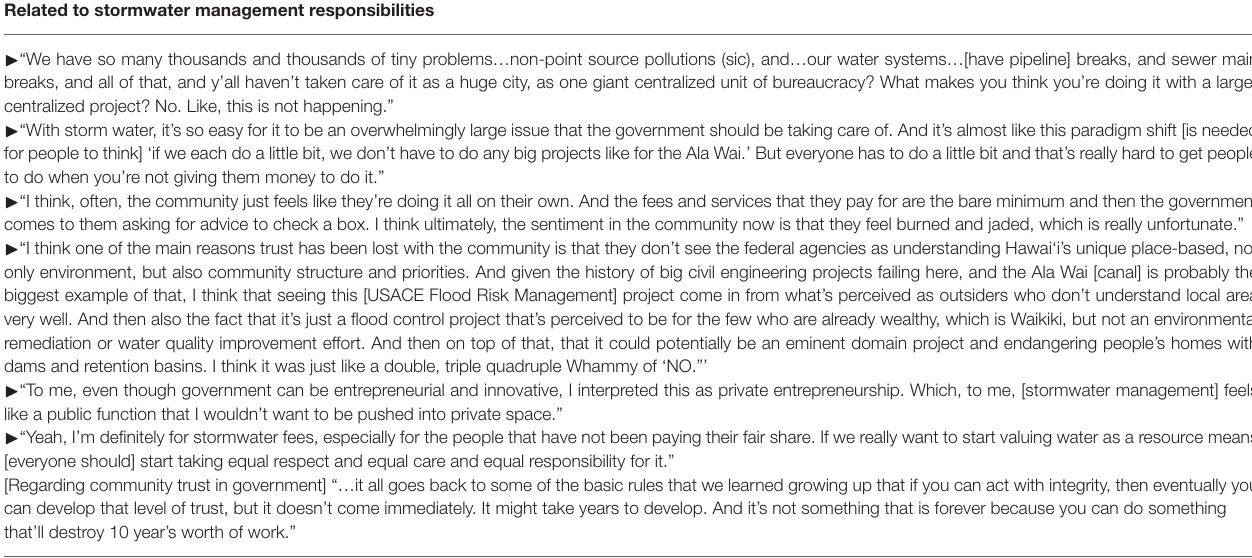
TABLE 10 | Notable quotes from study participants regarding their ideas about roles and responsibilities over stormwater management. Related to stormwater management